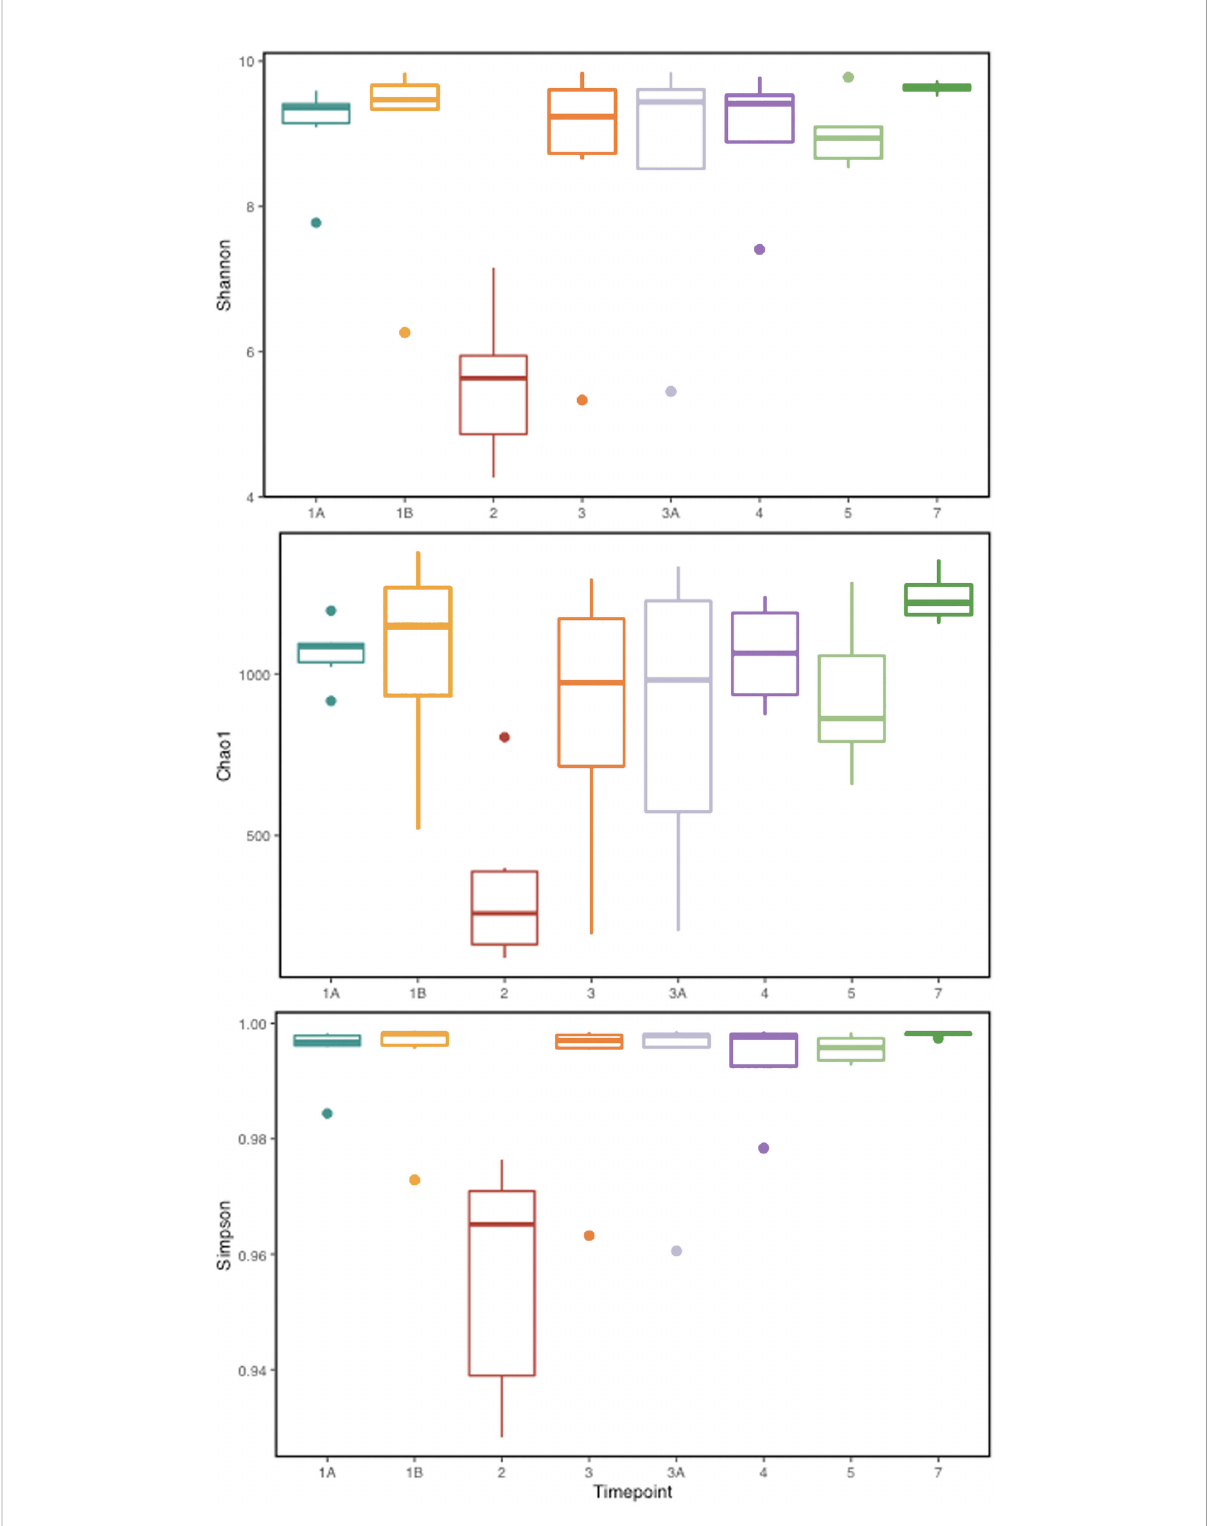
FIGURE 2 Alpha diversity metrics (Shannon, Simpson, and Chao 1 richness indices) for the gut microbial communities at various TPs during P. cynomolgi infection of rhesus macaques. All the panels point towards lowered microbial diversity, richness, and evenness during the peak P. cynomolgi infection